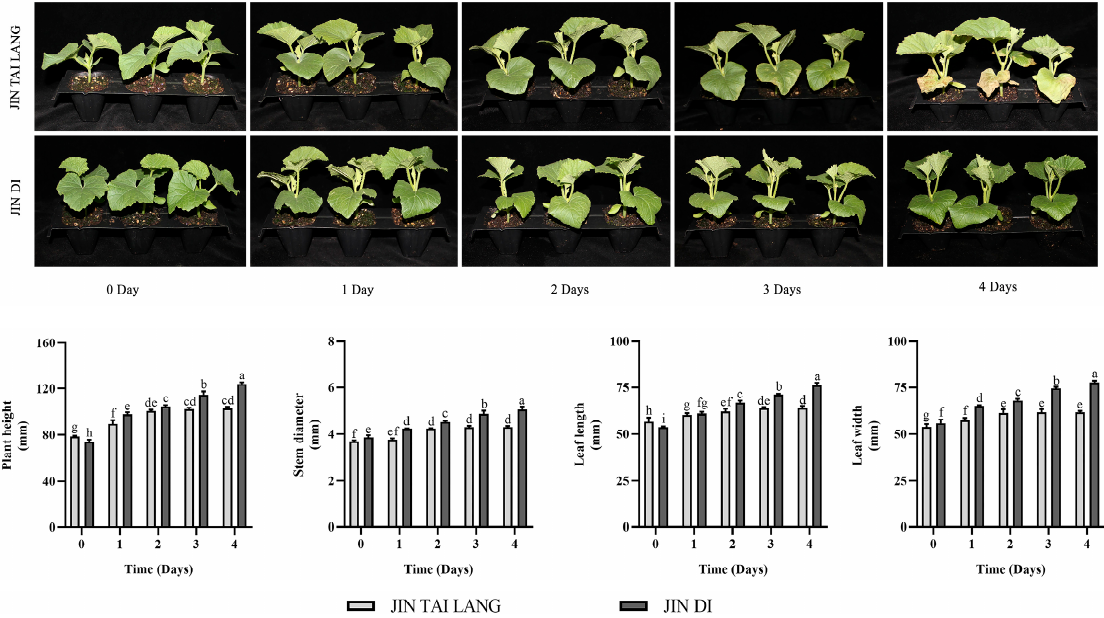
Figure 1. Changes in the melon growth morphology index on different days under HTH stress. Different letters indicate significant differences according to Duncan’s multiple range test at p < 0.05 using a one-way ANOVA. Values are represented as the means ± SD ( n =